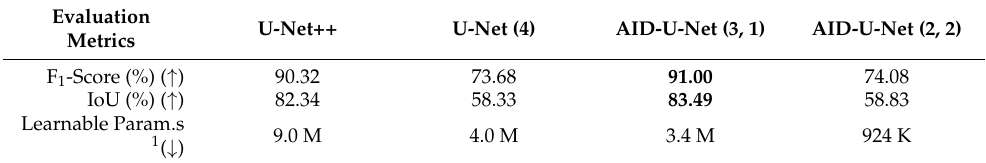
Figure 6. Summarized history for: ( a ) Loss of U ‐ Net, and ( b ) Intersection over Union (IoU) of U ‐ Net ( c ) Loss of AID ‐ U ‐ Net (3, 1), and ( d ) IoU of AID ‐ U ‐ Net (3, 1), ( e ) Loss of AID ‐ U ‐ Net (2, 2), and ( f ) IoU of AID ‐ U ‐ Net (2, 2). Table 3. Comparative Results between U ‐ Net with depth 4, AID ‐ U ‐ Net (3, 1) and AID ‐ U ‐ Net (2, 2), Table 3. Comparative Results between U-Net with depth 4, AID-U-Net (3, 1) and AID-U-Net (2, 2), applied to optical colonoscopy images of CVC ‐ ClinicDB for colorectal polyp segmentation. applied to optical colonoscopy images of CVC-ClinicDB for colorectal polyp segmentation. Evaluation Metrics Evaluation Metrics